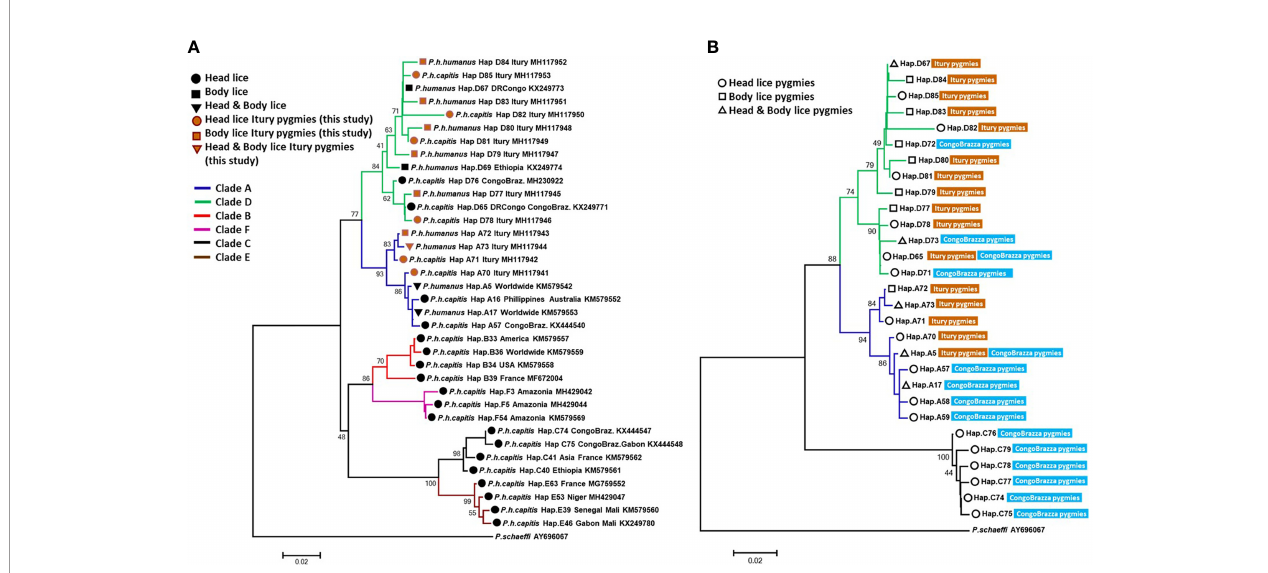
FIGURE 3 | The phylogeny of head and body lice from Mbuti pygmies based on the cytb gene. Maximum-likelihood phylogenetic tree showing the relationship of haplotypes identi fi ed in this study (A) with the most prevalent haplotypes of P. humanus and (B) haplotypes from head lice Congo Brazzaville pygmies. Phylogenetic inference was conducted in MEGA 7 using the maximum likelihood method under HKY + I + G model with 500 bootstrap replicates. There was a total of 270 positions in the fi nal dataset. The scale-bar represents a 2% nucleotide sequence